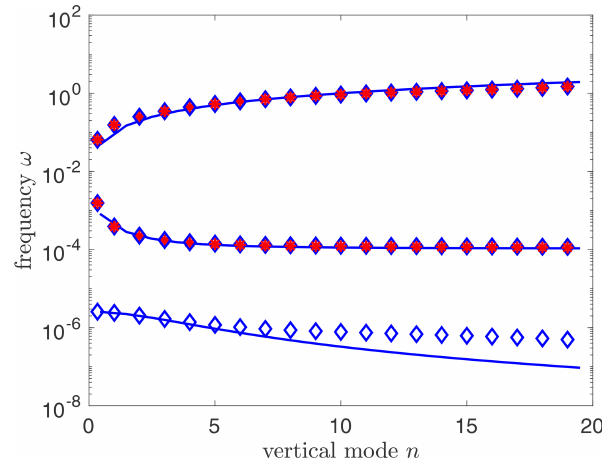
Figure 1. Analytical and numerical dispersion relation for the sys- tem of Eqs. (6)–(10). Solid blue curves, from top to bottom, are acoustic, gravity, and Rossby branches of analytical solutions for ω . Blue diamonds are negative numerical eigenvalues and red stars are positive numerical frequencies ω